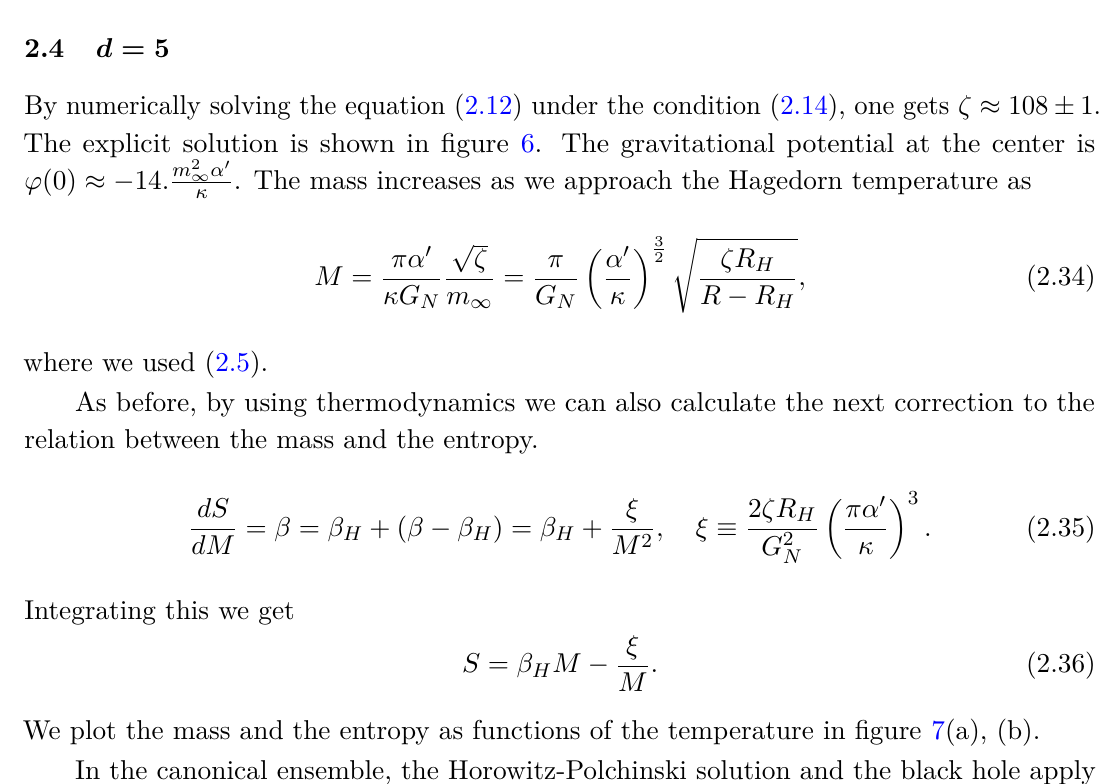
Figure 6 . Solution for d = 5 . (a) Plot of the rescaled profile ˆ χ (ˆ ρ ) . (b) Plot of the rescaled gravitational potential ˆ ϕ (ˆ ρ ) ≡ − R d 5 ˆ y | ˆ χ (ˆ y ) | 2 . The true values of χ and ϕ are related to the rescaled | ˆ x − ˆ y | 3 ones through (2.11) and